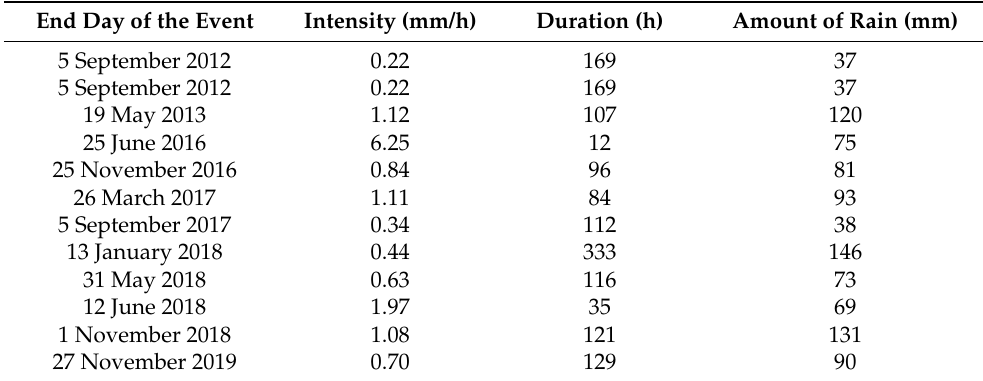
Figure 4. The set of rainfall thresholds and the calibration dataset of events. Table 2. Rainfall events associated with landslides in the calibration period.